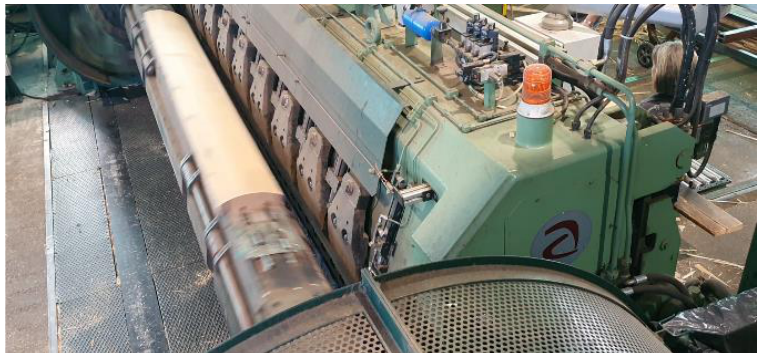
Figure 2. Rift cut veneer production in Spačva Ltd. (© Domagoj Mamić, 2021).